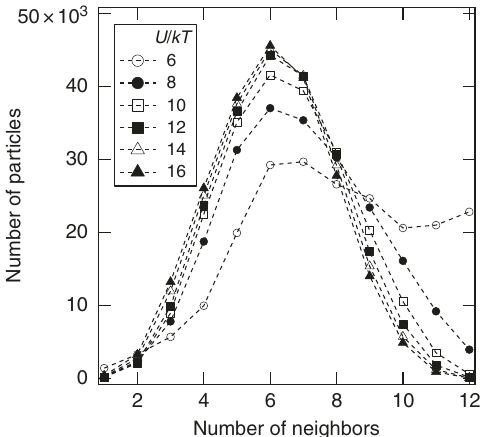
Fig. 3 The nearest neighbor distribution for particles within clusters. The l - balanced graph decomposition identi fi es minimally connected clusters among the different gels studied. The analysis itself is agnostic to whether the clusters themselves are rigid. By identifying minimally connected clusters in a homogeneous network, there is a bias toward clusters with large number of internal bonds. To quantify this effect and con fi rm that the clusters are indeed rigid, we examine each cluster in isolation and compute the number of bonded neighbors each particle within the cluster possesses. This number excludes any neighbors that might reside within another cluster. The plot shows this distribution for all the simulated gels. Clearly, the mean number of nearest neighbors is larger than six for all cases. Therefore, the clusters exceed the Maxwell iso-staticity condition and contain a rigid core that can serve as an elastic sub-unit for the